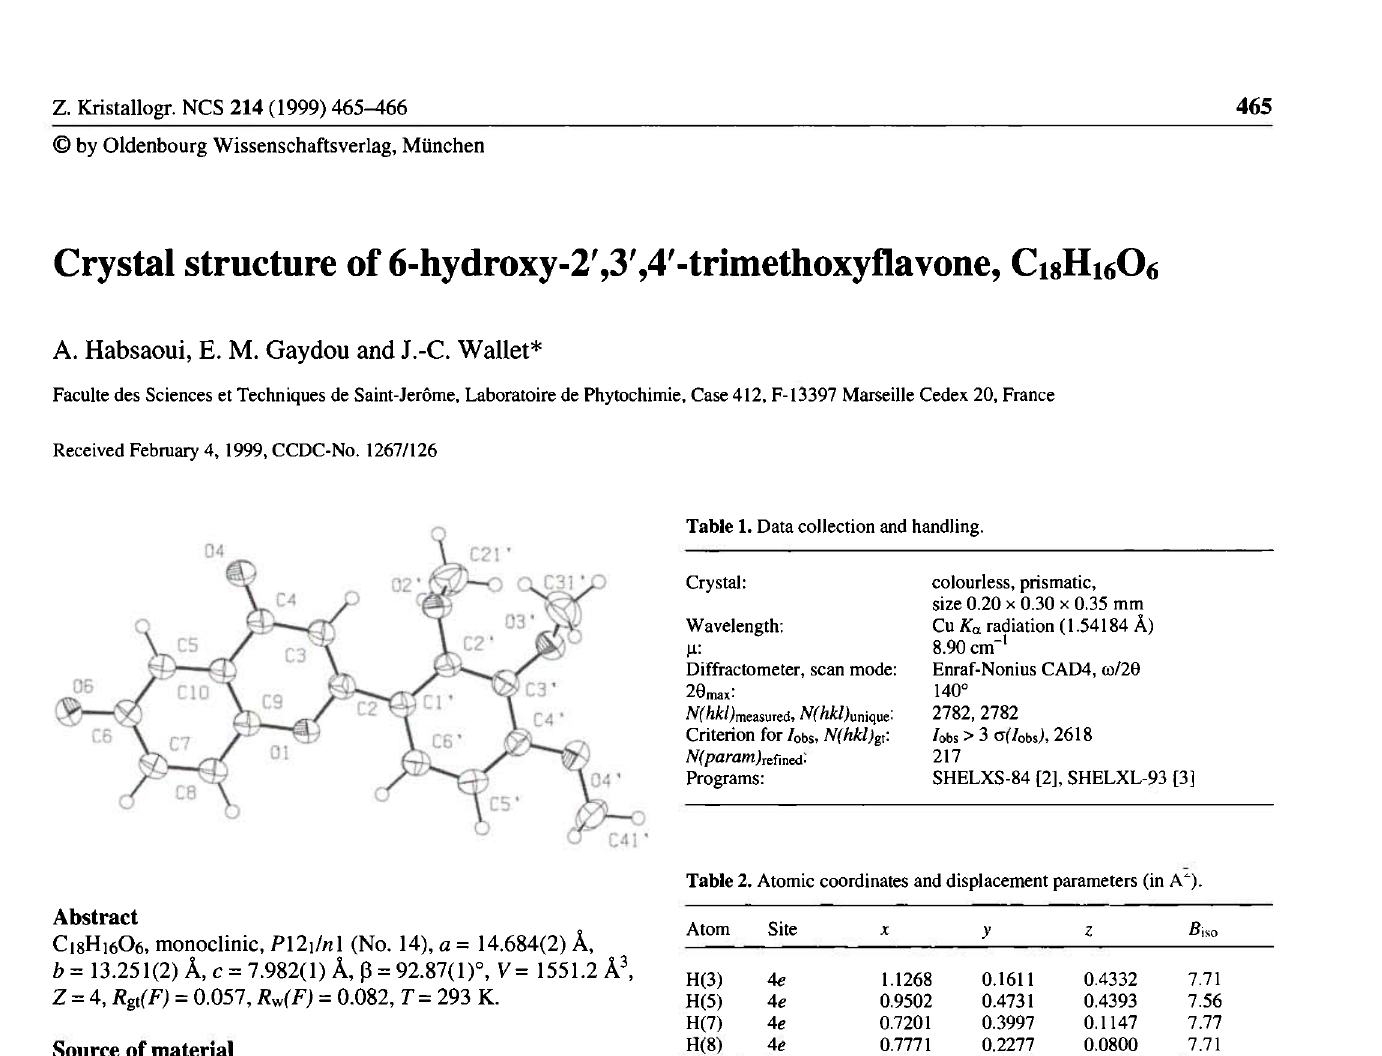
Table 2. Atomic coordinates and displacement parameters (in A ).